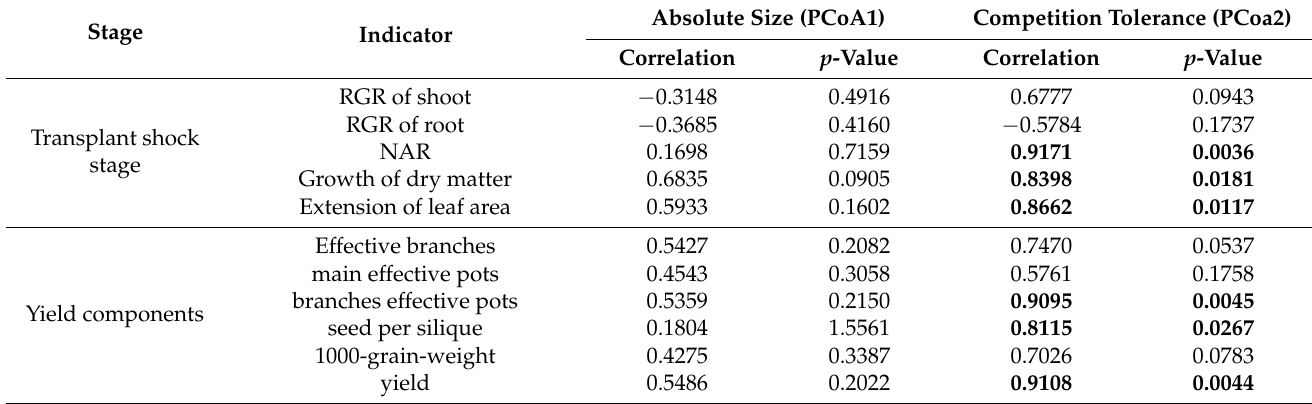
Table 5. Partial correlation analysis of seedling growth characteristics between pre and post